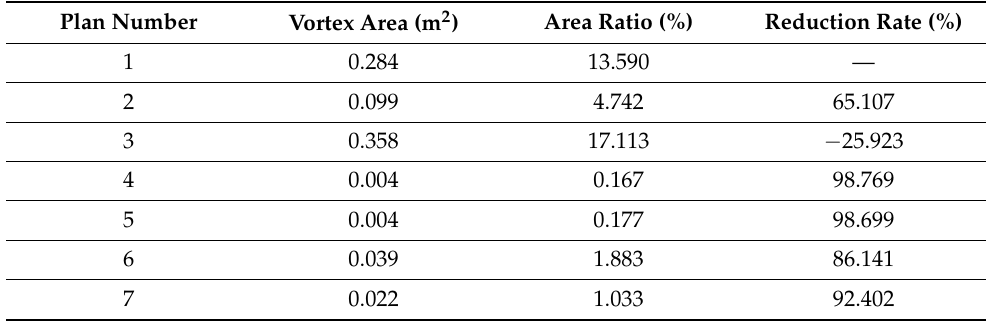
Table 5. Vortex parameters of each plan.